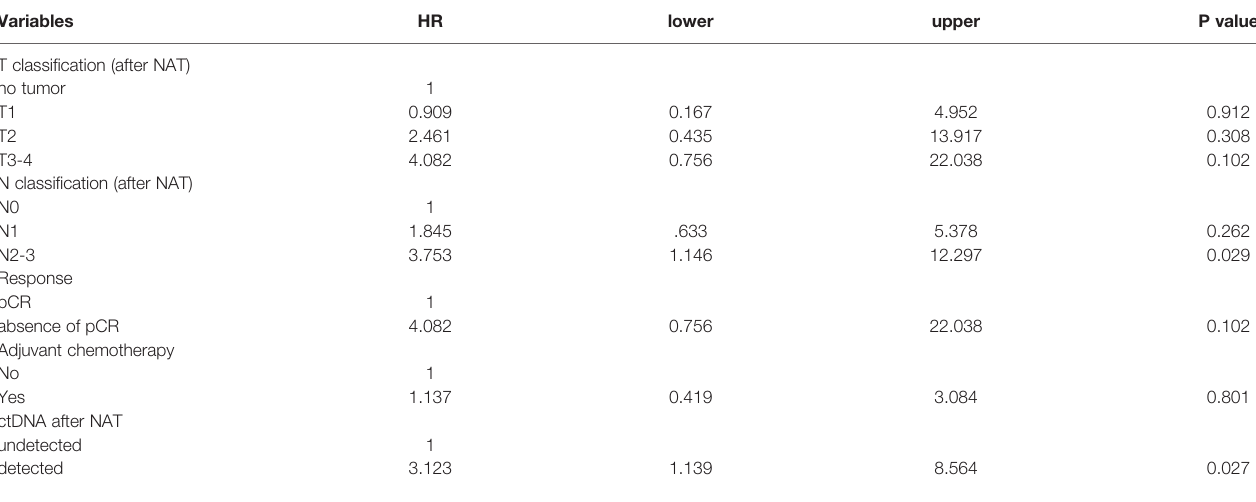
TABLE 3 | Multivariate analysis of recurrence-free survival in patients with Her2(+) breast cancer and TNBC. Variables HR lower upper P value T classi fi cation (after NAT) no tumor 1